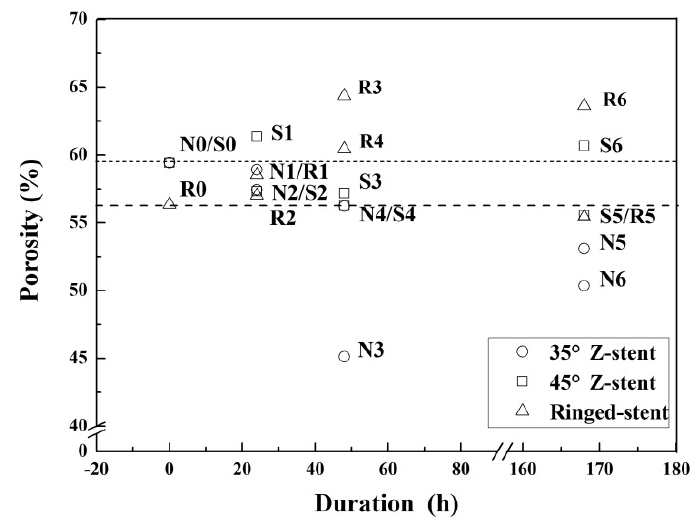
Figure 10. Porosity of the fabrics of the stent ‐ grafts.